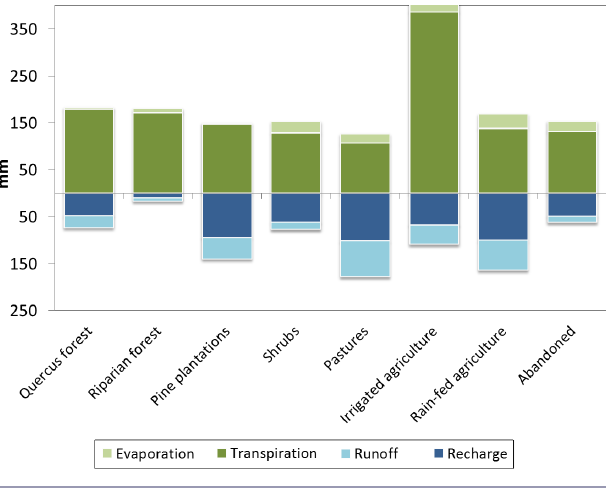
Fig. 6 . Land ecosystem requirements and surface and groundwater recharge density per land use land cover (LULC) type